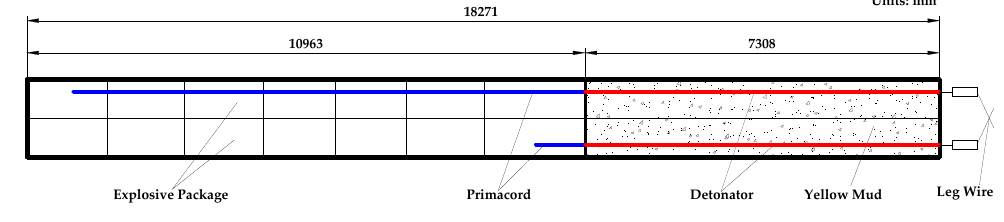
Figure 19. Schematic of a blasthole loaded with explosive.